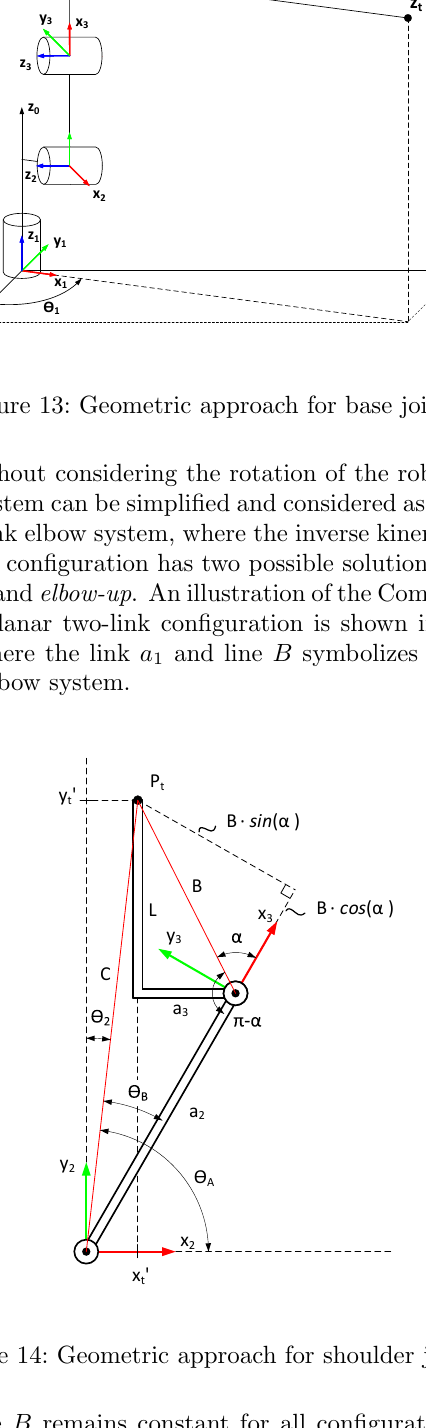
The tool-point vector components given relative to the coordinate frame of the shoulder joint ( x 2 , y 2 , z 2